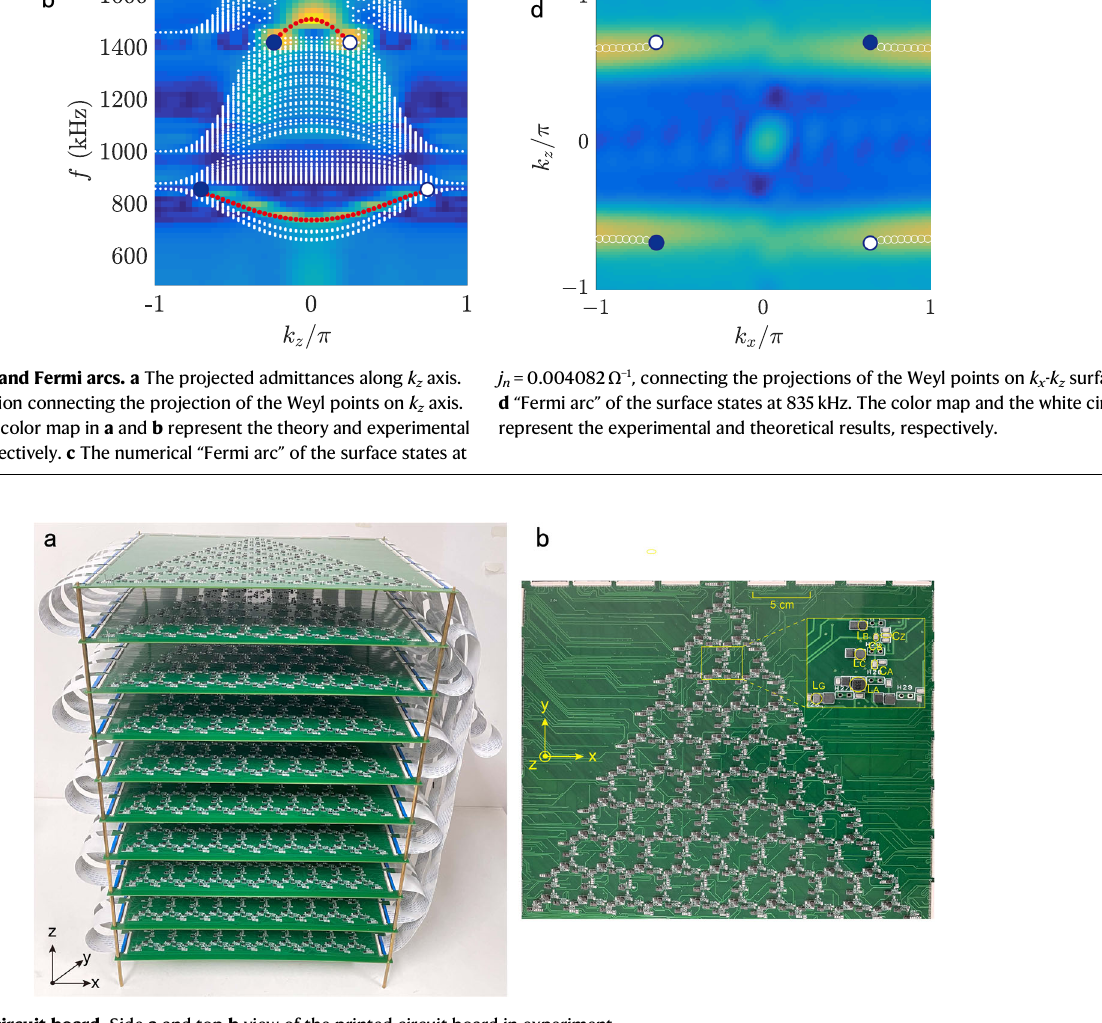
Fig. 5 | The printed circuit board. Side a and top b view of the printed circuit board in